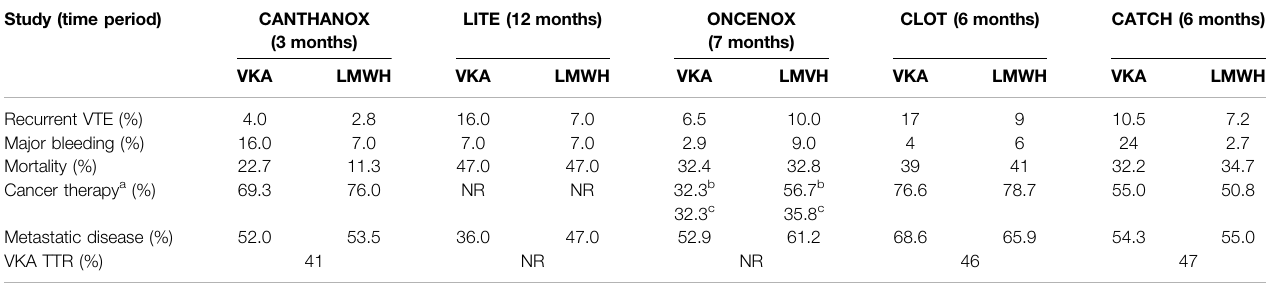
TABLE 3 | Summary of randomized trials comparing VKAs with LMWH (Meyer et al., 2002; Deitcher et al., 2006; Hull et al., 2006; Lee et al., 2015). Study (time